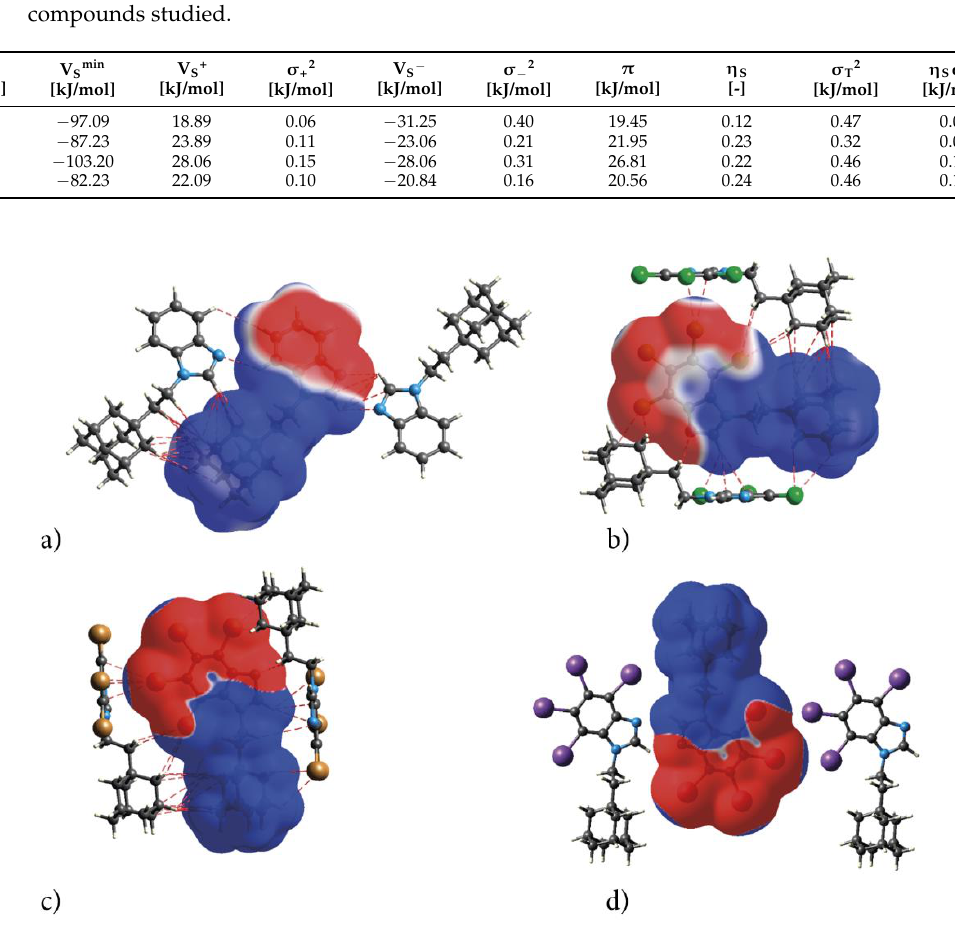
Figure 7. Electrostatic complementarity upon crystal packing in adamantylated 4,5,6,7-tetra-halogeno-1 H -benzimidazoles: electrostatic potential mapped onto the Hirshfeld surfaces of symmetry-related neighbouring molecules ( a ) AB, ( b ) tClAB, ( c ) tBrAB and ( d ) tIAB. Color scale is −0 .01 (red) to 0 (white) to 0.01 a.u. (blue). The negative ESP (repulsive) on both sides of the molecule occupy a C-shaped region, symmetrical on the top and bottom sides of the molecule.